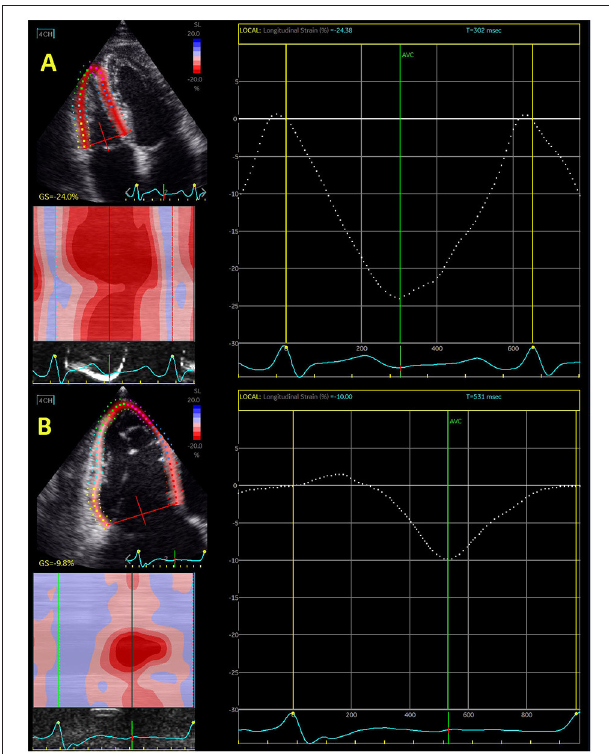
FIGURE 1 | Echocardiography-derived right ventricular global longitudinal strain in control subjects (A) and patient with severe functional tricuspid regurgitation (B)